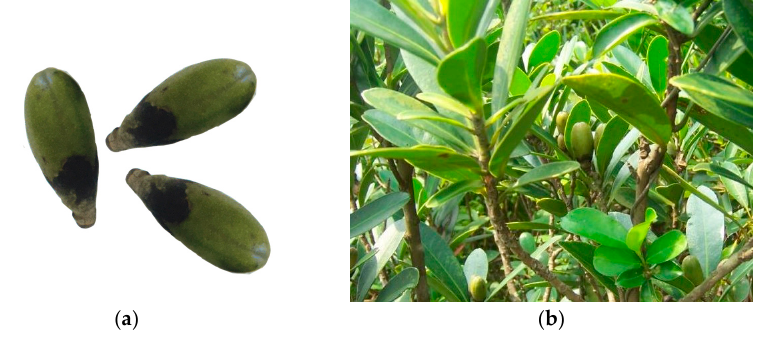
Figure 1. The fruit ( a ) and leaves ( b ) of Gordonia axillaris .